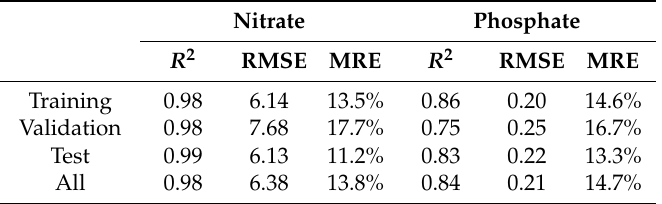
Figure 6. Comparisons of in situ samples and model estimates for nitrate and phosphate. The training, validation, and test data are represented by different symbols. Table 2. The coefficient of determination ( R 2 ), root-mean-square error (RMSE), and mean relative error (MRE) between in situ and estimated nutrients. All measured data were divided into three groups for training, validation, and testing.